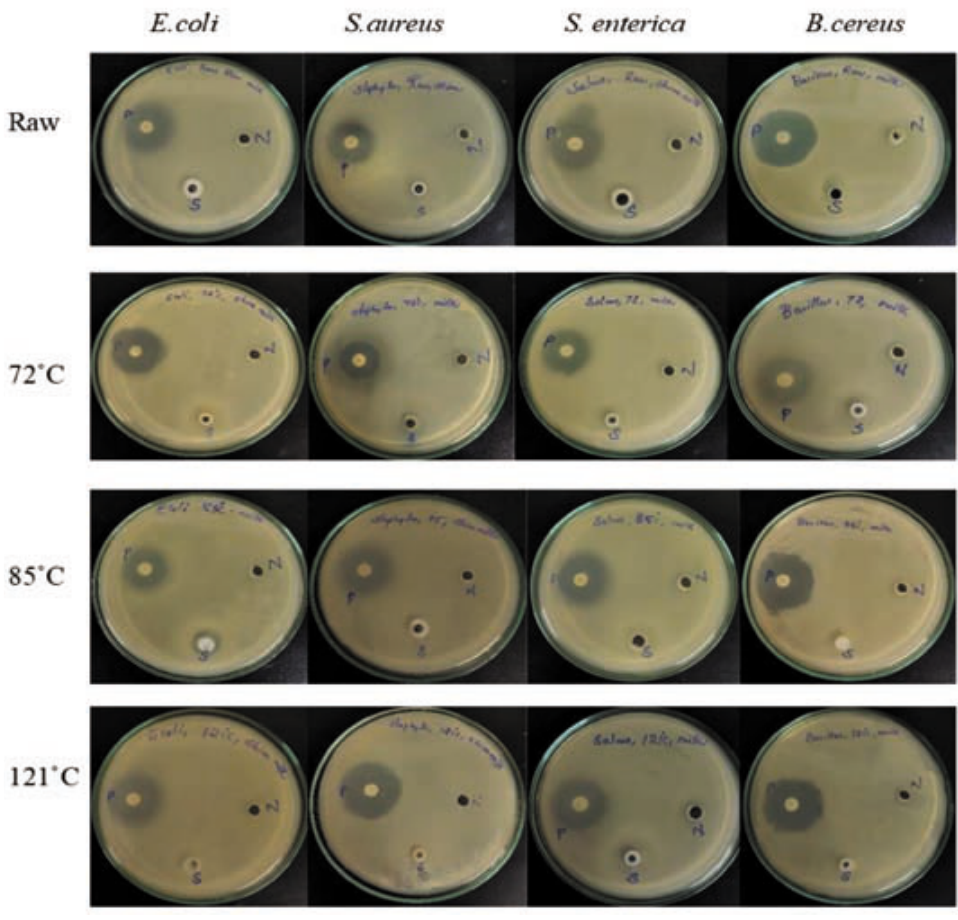
Fig.1. Antibacterial activity of the skim milk made from goat milk (raw, 72°C/15sec, 85°C/10min, 121°C /15min.) P-positive control, N-negative control,